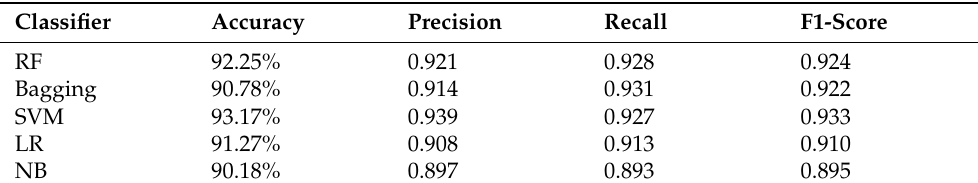
Table 28. Experiments with ML models and concatenated features and all lexicons on Arab TextBlob sentiments.